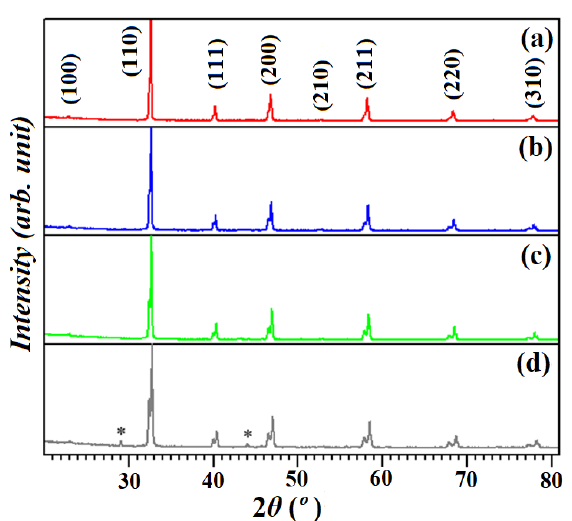
Figure 1. XRD results of ( a ) STC, ( b ) STCM3, ( c ) STCM5, and ( d ) STCM7 materials. The “ * ” mark indicates cobalt impurity phases presence in the sample.